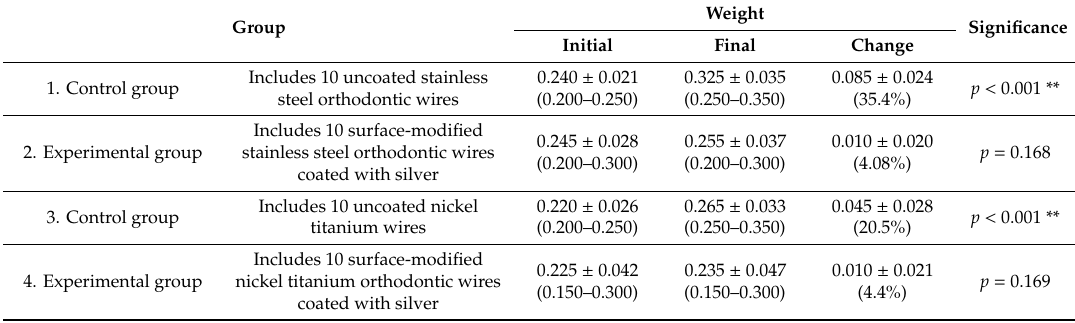
Table 2. Groups of archwires used for the antiadherent properties of surface-modified orthodontic archwires and comparison of weight: initial, final and changes in weight of wires [32].